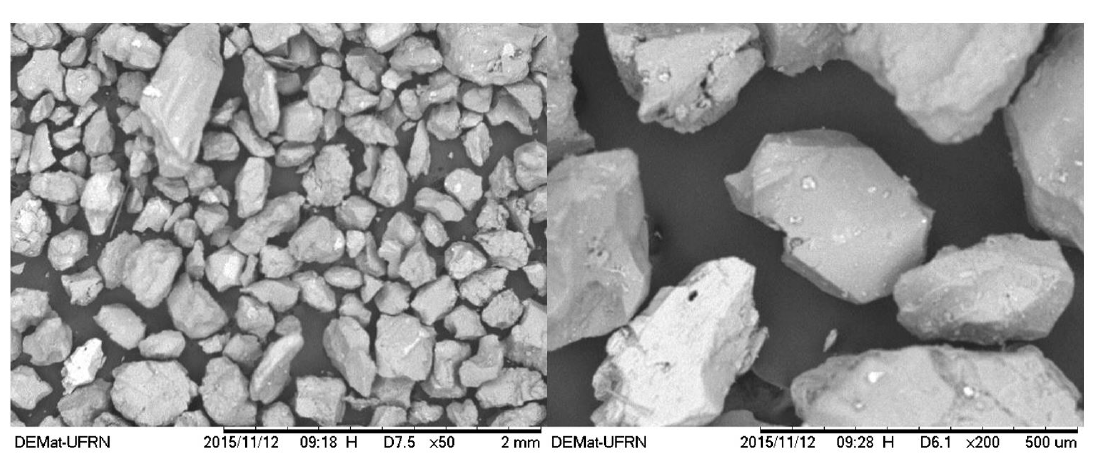
Figure 3. SEM image of obtained natural aggregate sample.